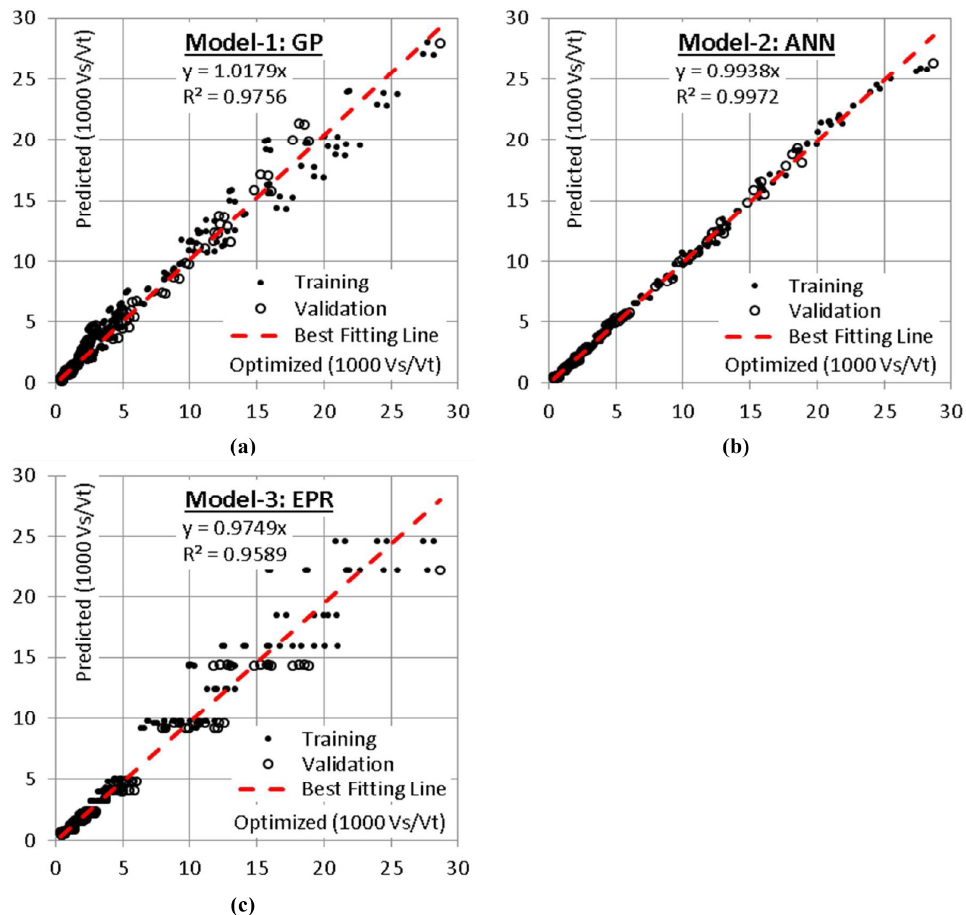
Figure 5. Relation between predicted and calculated 1000 Vs/Vt values using the developed models. ( a ) GP model, ( b ) ANN-model and ( c ) EPR model.